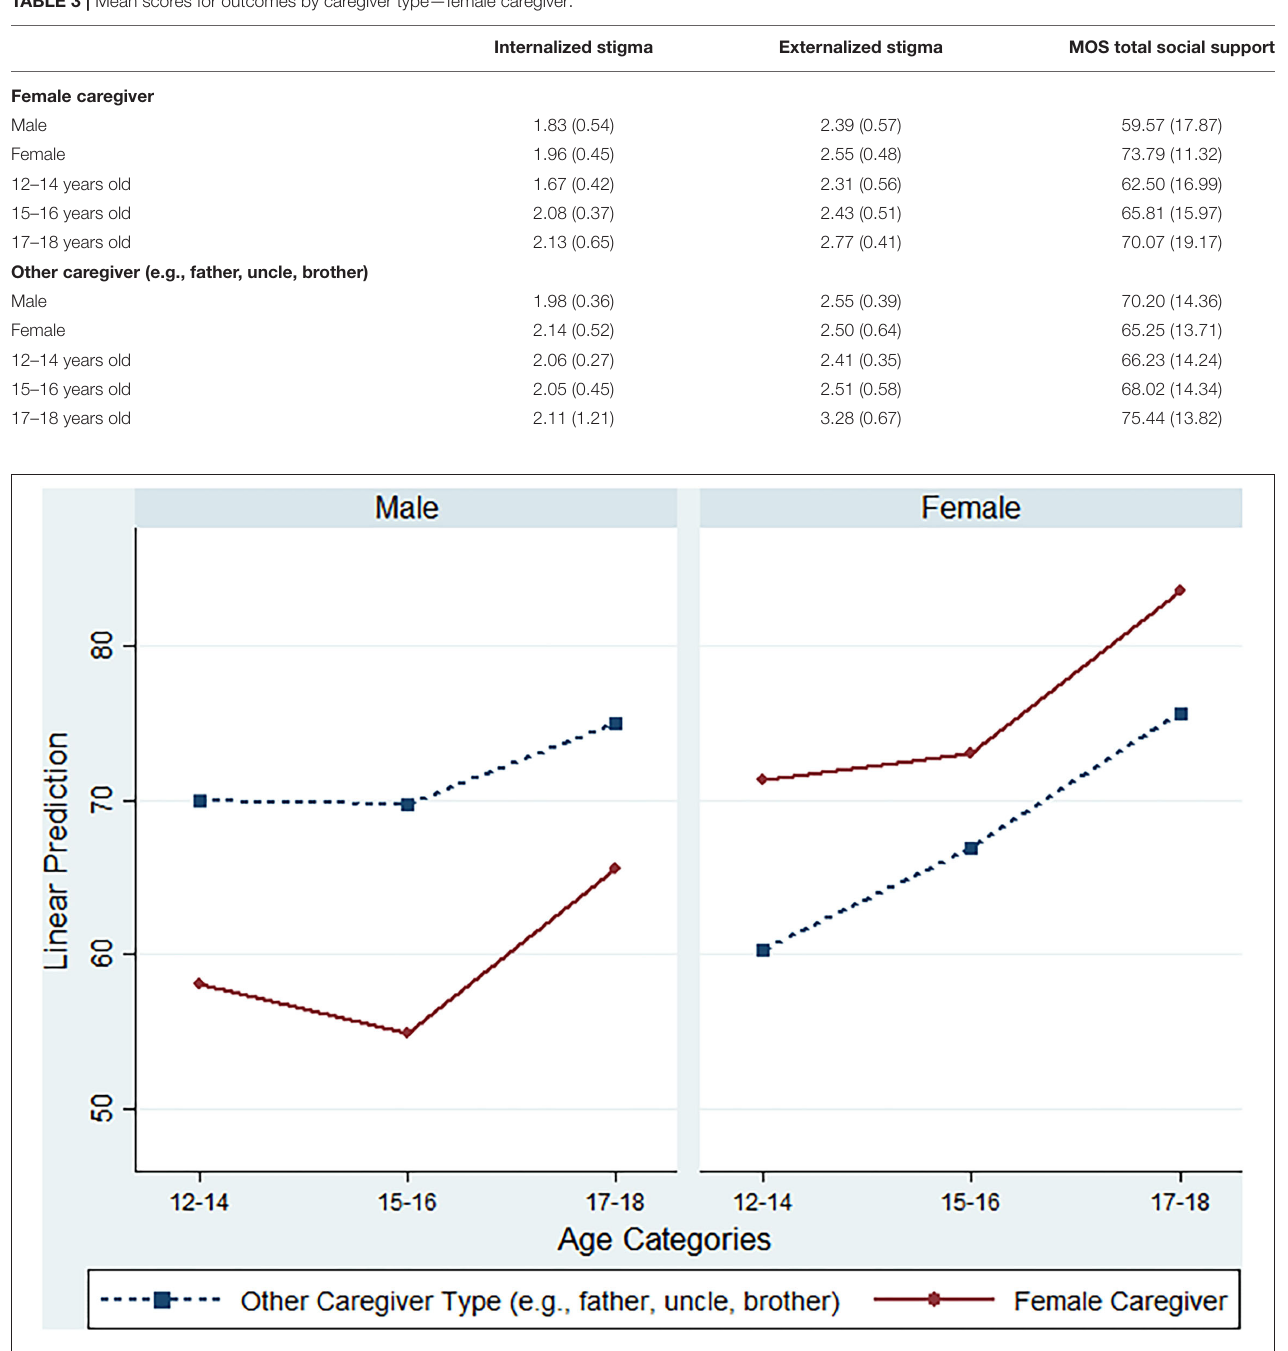
TABLE 3 | Mean scores for outcomes by caregiver type—female caregiver.